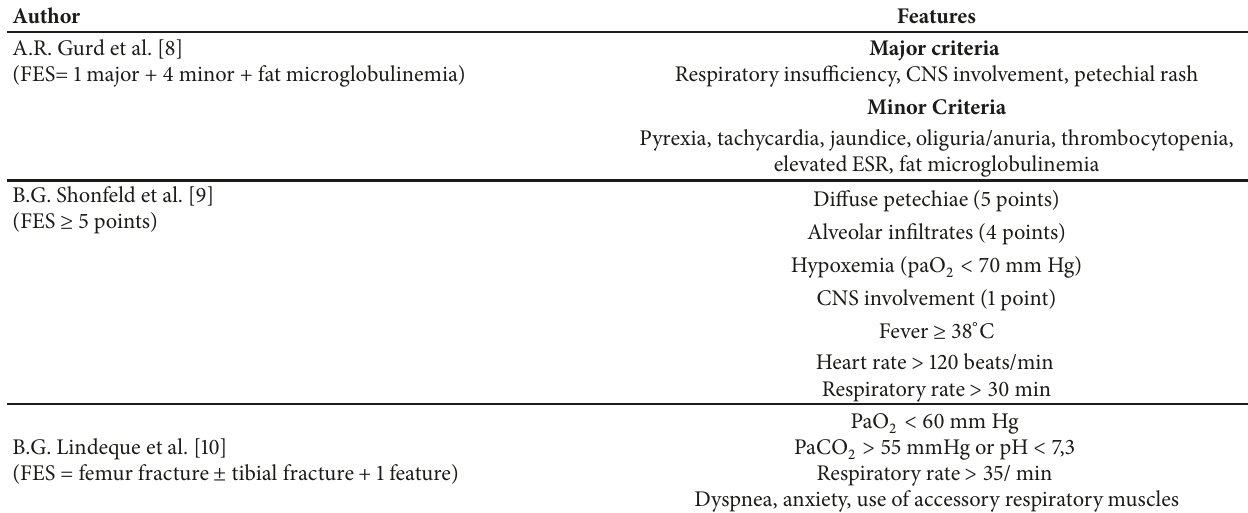
Table 1: Scoring systems used for the diagnosis of FES. CNS: central nervous system; ESR: erythrocyte sedimentation